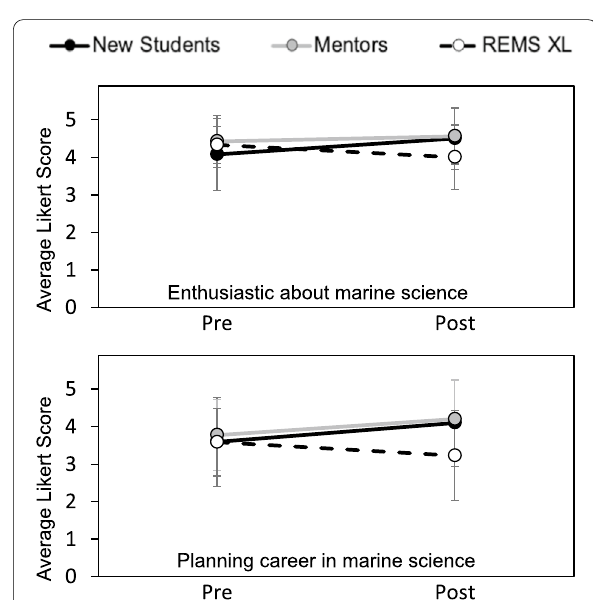
Fig. 16 Interest: Comparing marine science interest scores among student groups. Average New Student ( N REMS XL student ( N 12) responses to REMS survey items (1 = all, 5 A great deal) relating to interest in marine science and marine = science